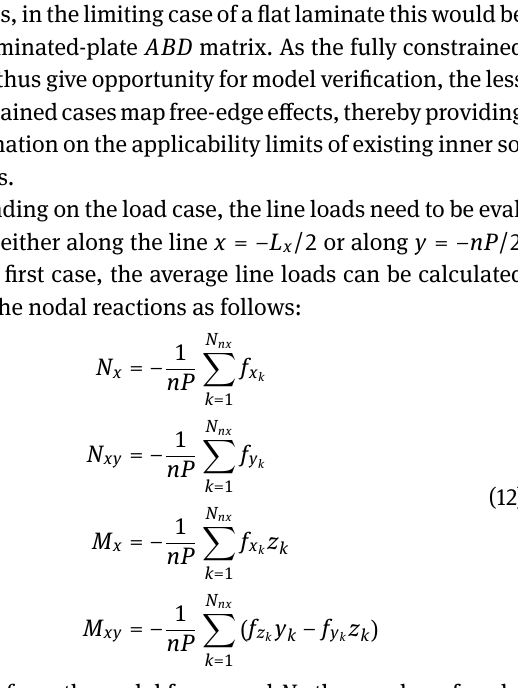
Figure 7 indicates. This situation is simulated by applying the rotation φ